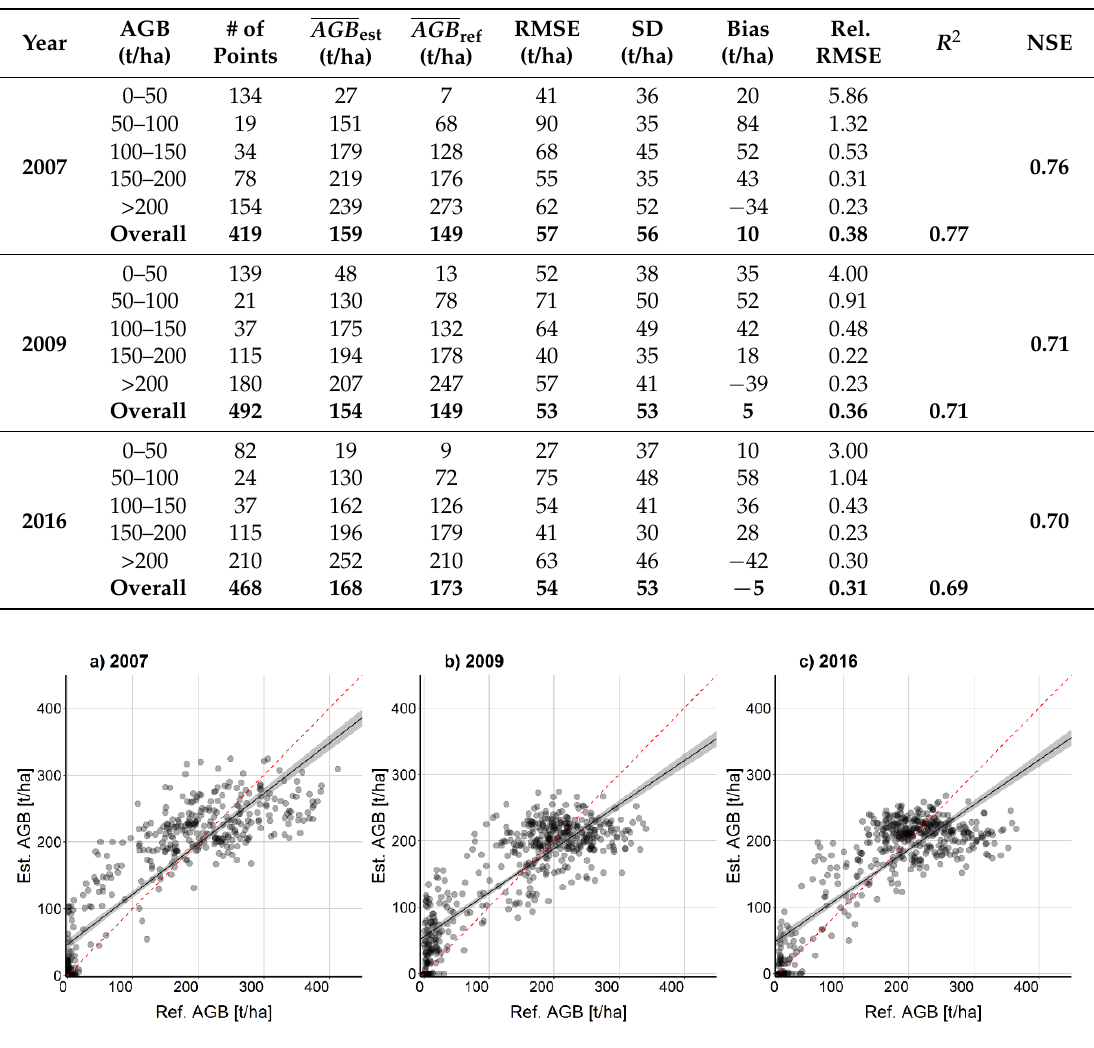
Figure 6. Linear regression of estimated above-ground biomass and reference above-ground biomass using approximately 500 randomly-generated points across the reference layer for each year (red dashed line = 1:1 line; black line = linear trend including confidence bounds).